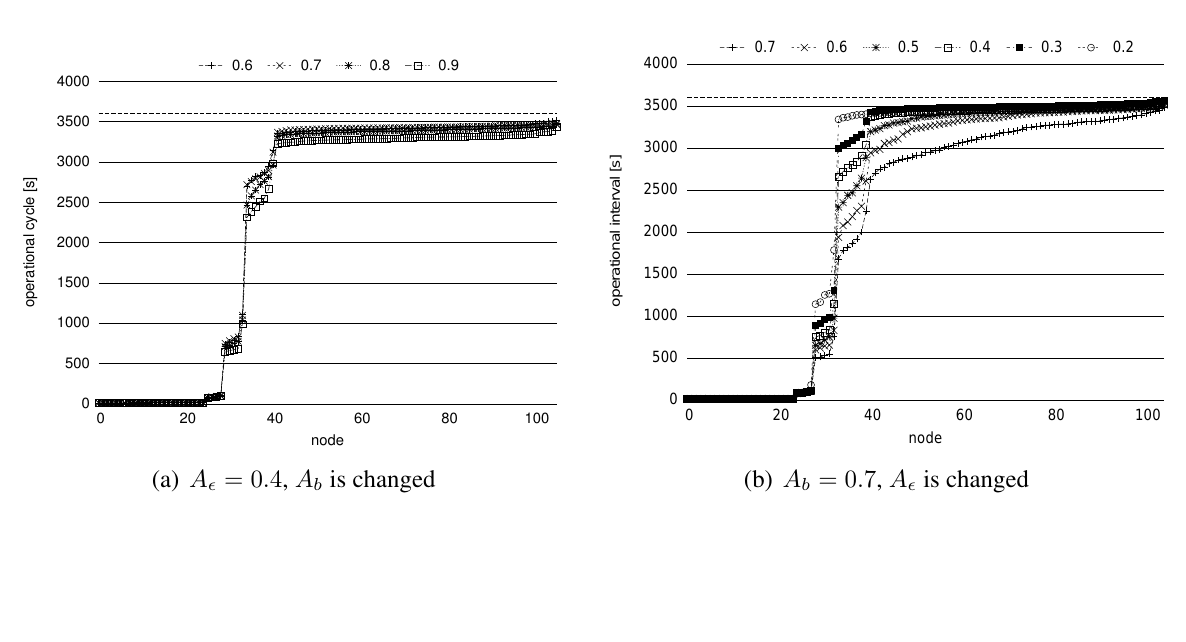
or A are b (cid:15)